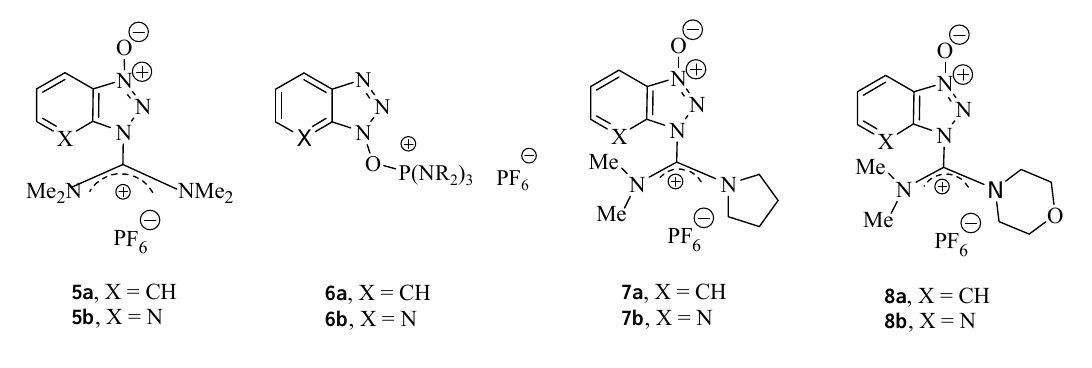
Figure 2. Structure of uronium/iminium